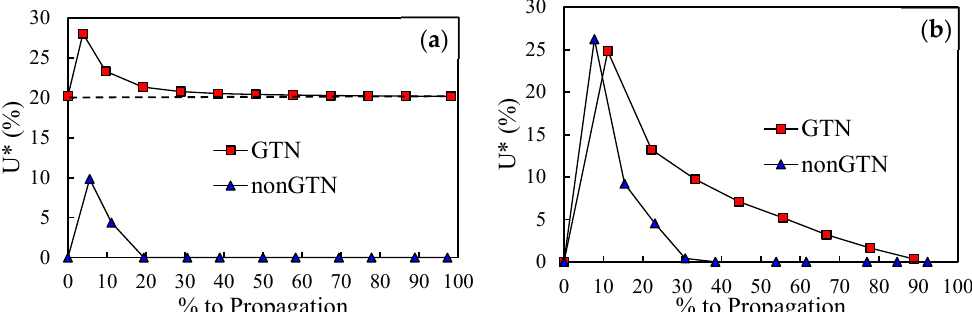
Figure 8. Crack closure level with and without GTN. ( a ) a 0 = 11.5 mm, between the 25th and 26th crack propagations. ( b ) a 0 = 21.5 mm, between the 36th and 37th crack propagations. The results are presented in percentage up to propagation, which is an analogous scale to the pseudo time.